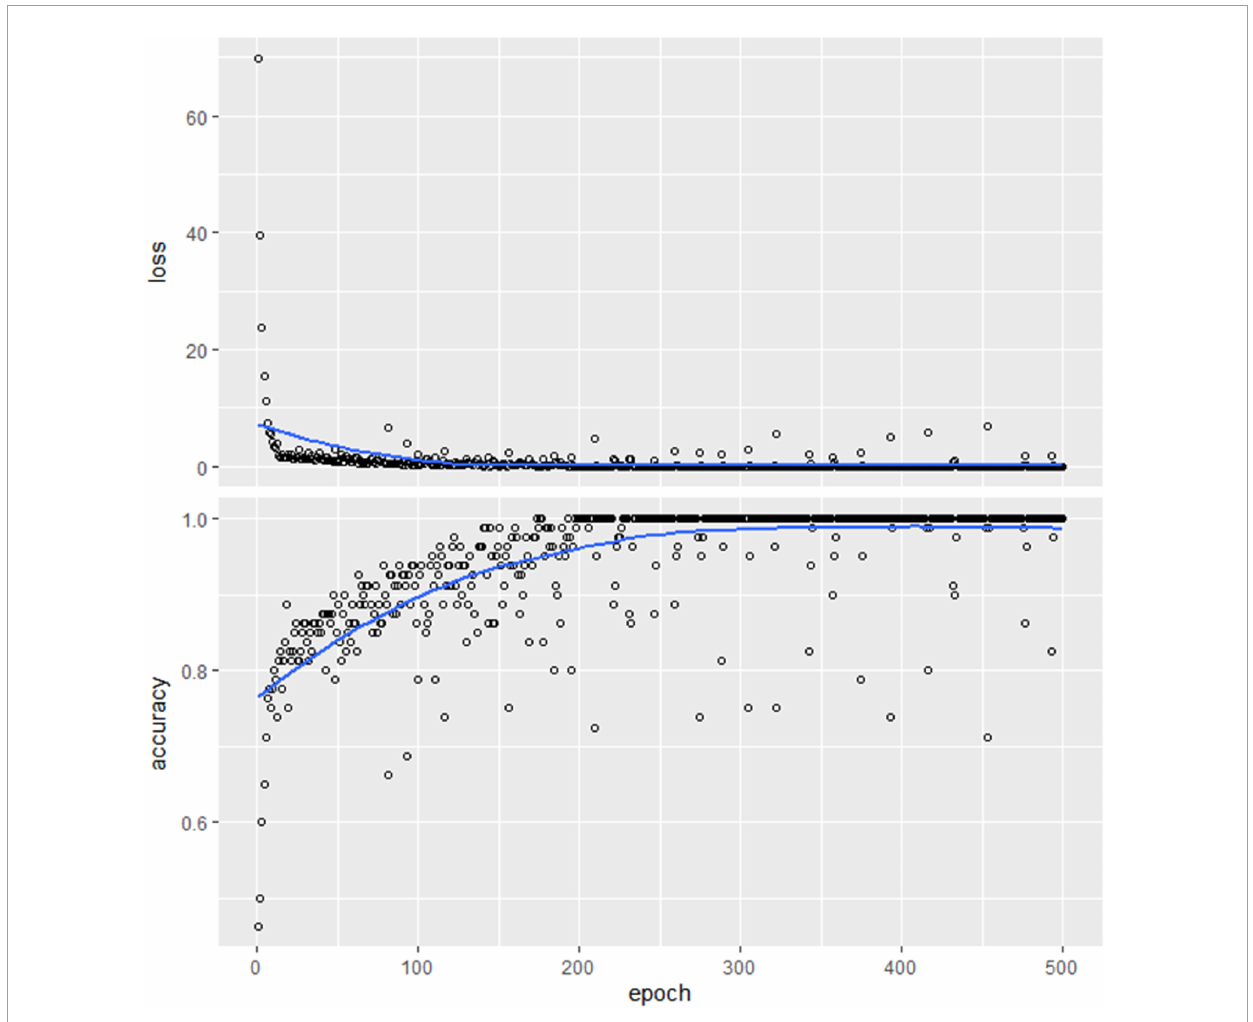
FIGURE13 Training and validation accuracy changes with the number of epochs using DNN.